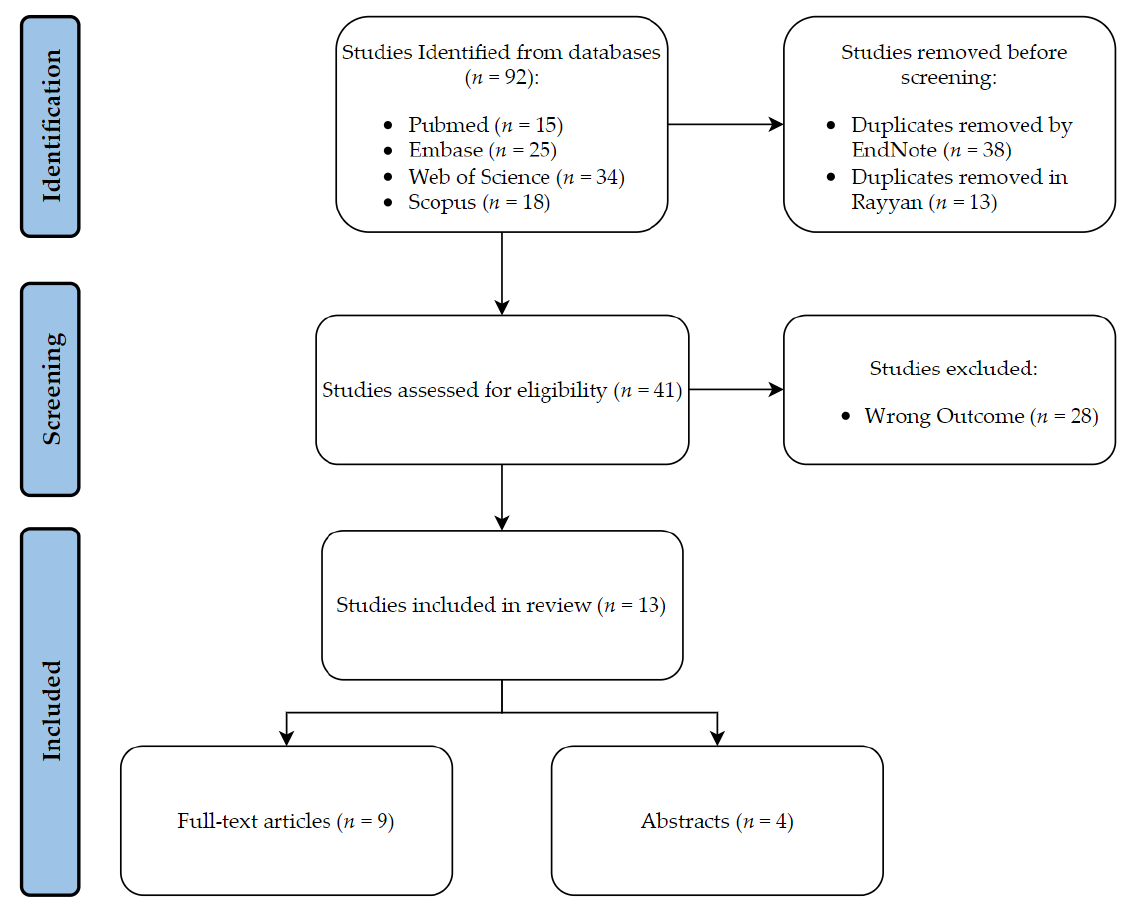
Figure 1. Schematic representation of the review process. Table 1. Data extraction summary of the included studies.